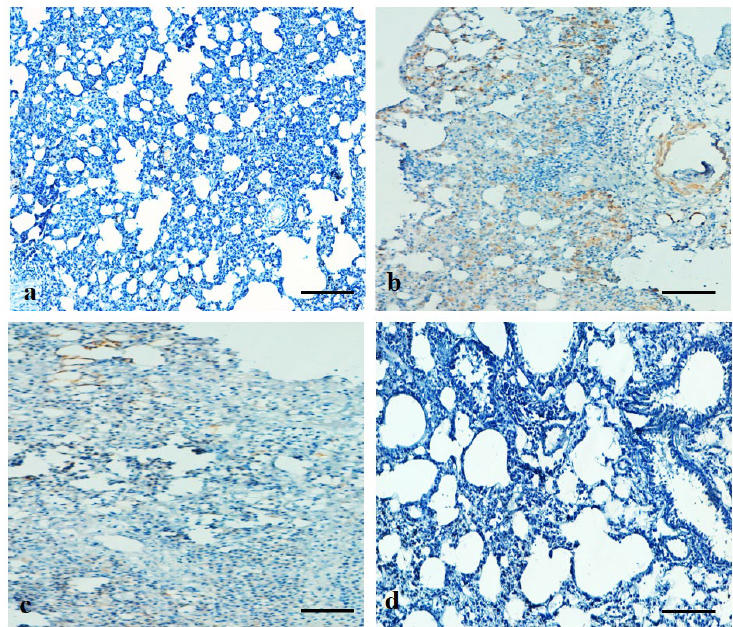
Figure 10. The expression pattern of Bax was evaluated. ( a ) in the control group, there was no expression of Bax protein; ( b ) in the disease control, Bax protein expression was high ( c ) in the ADE plus B(a)P treatment group, the expression of Bax protein was decreased ( d ) In ADE-treated group only, there was no expression of Bax protein. (Scale bar = 100 µm).